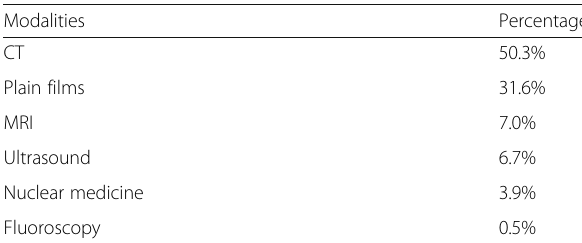
Table 3 Modalities of cases discussed in the educational